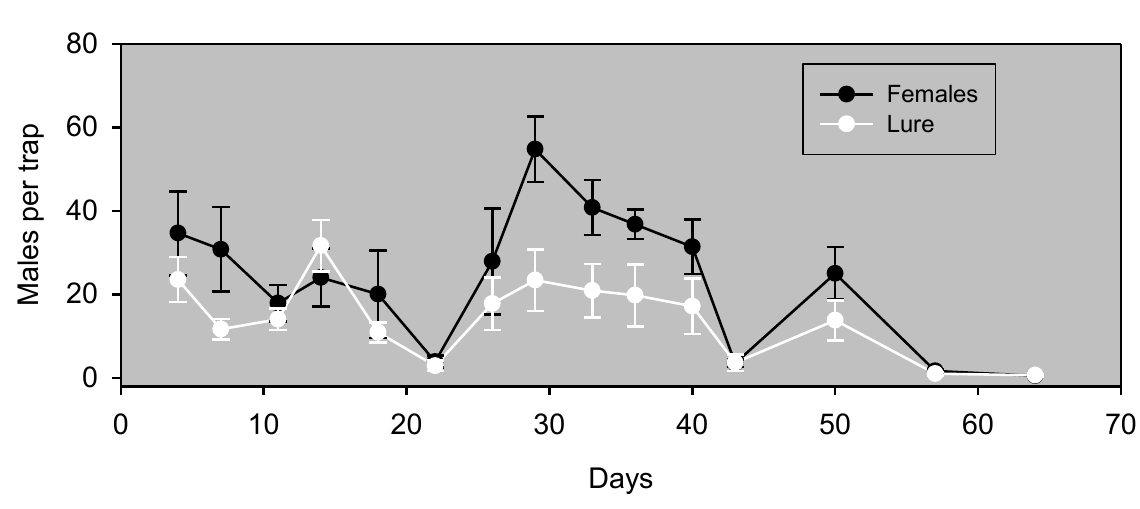
Figure 1. Males captured (mean ± SE, n = 8) in wing traps baited with unmated females vs . emitters. Experiment 5 was conducted in almonds and began on September 15, 2011. Blocks were 29 m apart, and traps within blocks were 13 m apart.